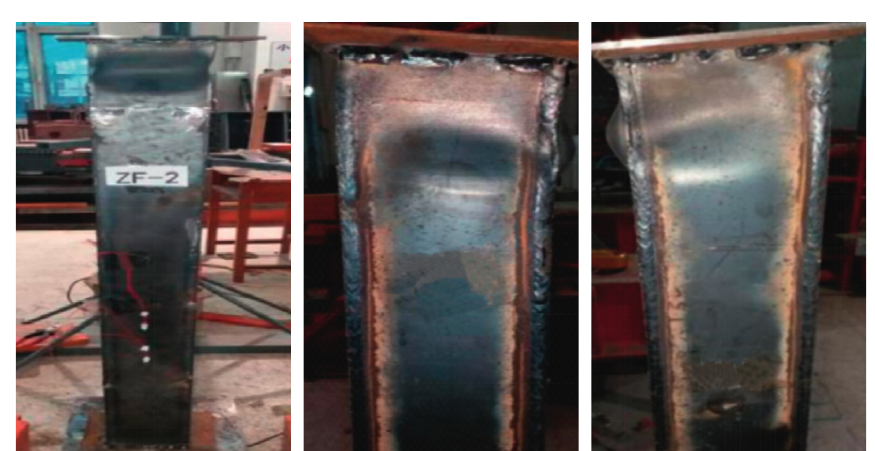
Figure 24: ZF-2 failure mode.